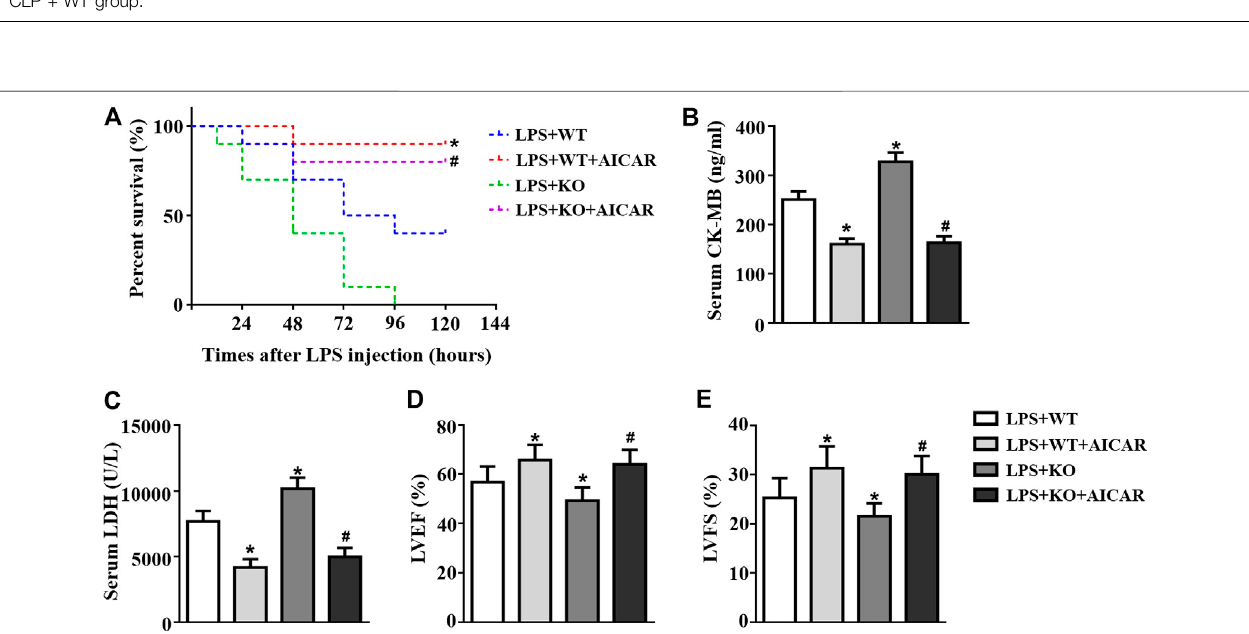
FIGURE 10 | AMPK activation abolishes the deterioration effect of Il12a deletion on LPS-induced cardiac dysfunction. (A) Effect of Il12a de fi ciency on the survival rate after CLP treatment (n (cid:1) 10). (B,C) CK-MB and LDH serum levels were assessed in each group (n (cid:1) 4). (D,E) Echocardiographic analysis ofLVEF and LVFS in each group (n (cid:1) 4). * p < 0.05 compared with the LPS + WT group; # p < 0.05 compared with the LPS + KO group.